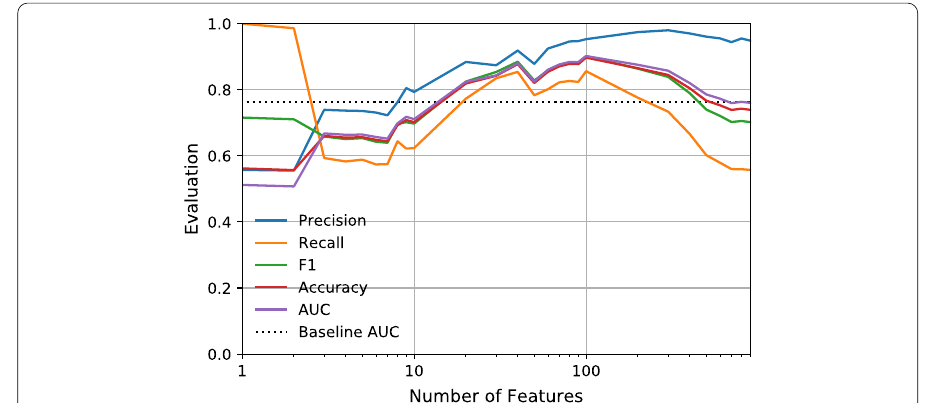
Fig. 9 A comparison of the engagement prediction of the baseline model vs feature optimized model